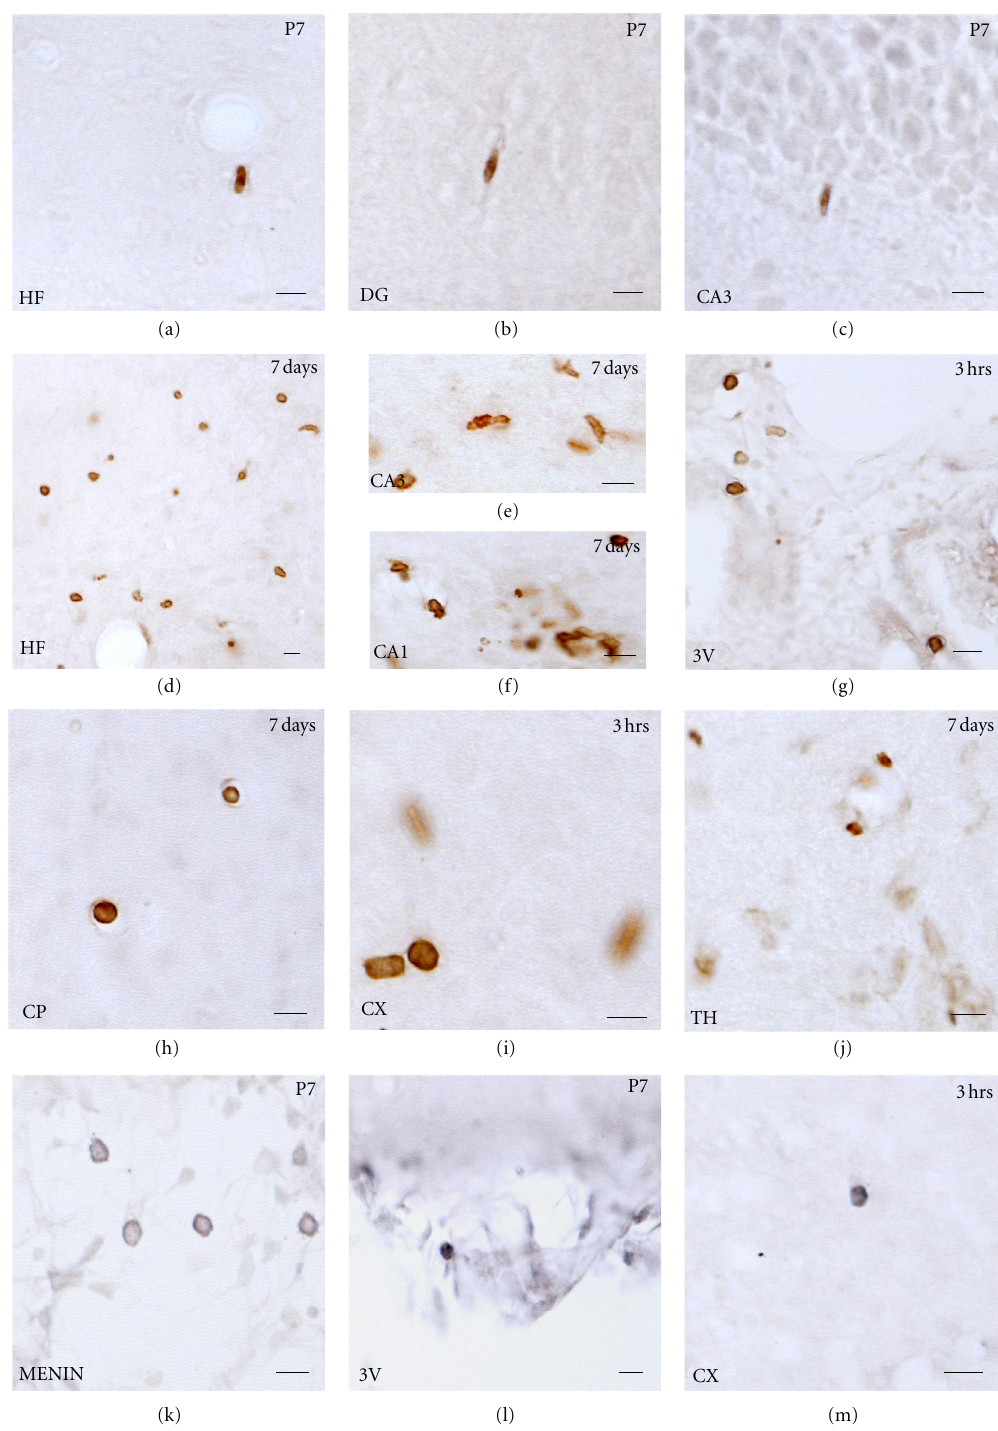
Figure 12: Leukocyte infiltration is monitored by analysing neutrophils (Ly6B2 staining) and T-lymphocytes (CD3 staining). Ly6B2 staining in the control animals at P7 shows a few neutrophils inside the blood vessels in the hippocampal fissure (a), in DG (b), and in the CA (c) regions. In the hippocampus the maximum density of cells is observed at 7 days after hypoxia especially in the hippocampal fissure (d); CA3 (e) and CA1 (f). In caudate-putamen an increase is observed at 7 days after hypoxia (h). In the ventricles (g) and the neocortex (i) the maximum quantity of neutrophils is observed at 3 hours after hypoxia. No significant di ff erence was observed in the thalamus (j). CD3 staining in the control animals shows the presence of lymphocytes in the meninges (k) and in the ventricles (l). Finally, scattered cells are observed in the neocortex (m). Scale bars: 10 μ m. Hf: hippocampal fissure; DG: Dentate gyrus; CA: cornu